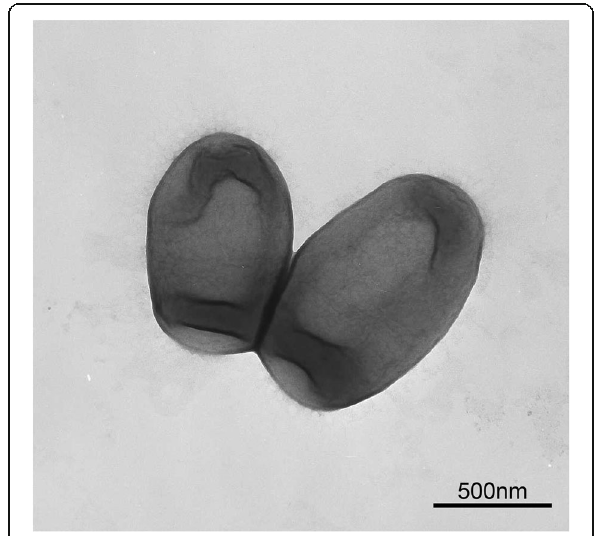
Fig. 1 Transmission electron microscopic image of N. dokdonensis